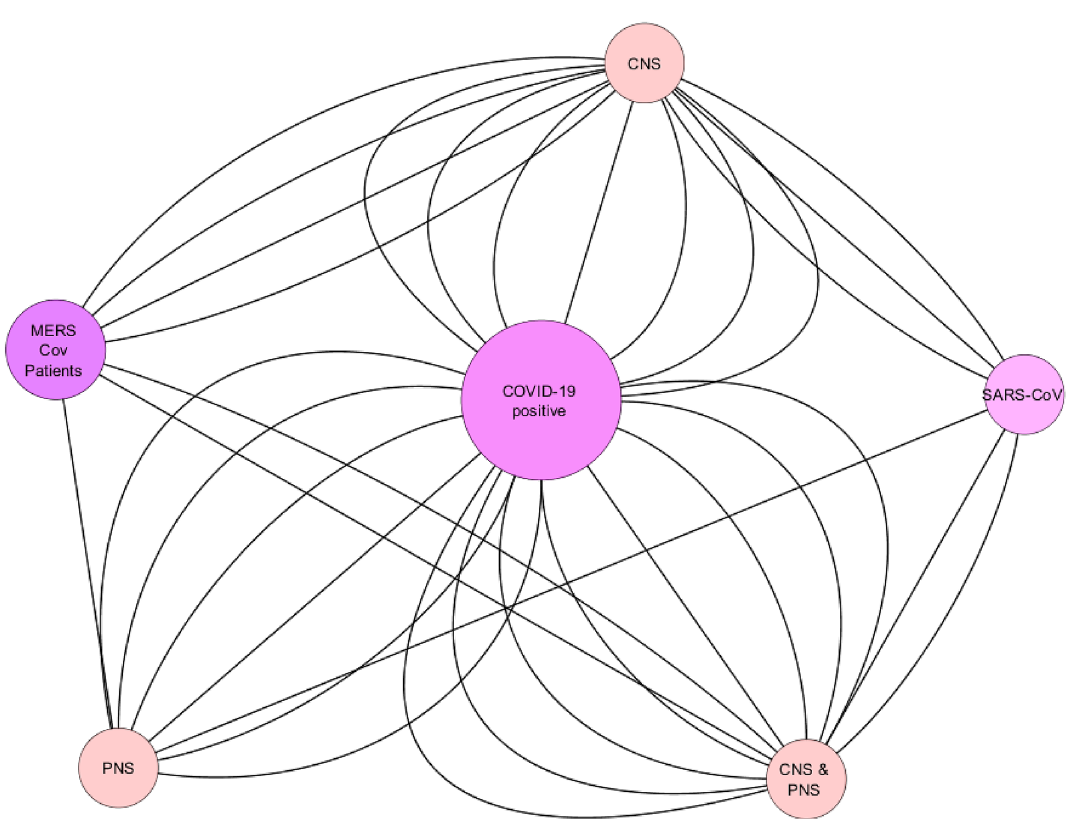
Figure 11. Overall Network analysis which showed the relationship with three main pandemics i.e., SARS- 2002, MERS-2012 and COVID-19 with the CNS, PNS or combined manifestations. Note : The size of node defines the degree of relation with the individual neurological symptoms and increased number of edges give the increased relation with the respective nodes. (Edges showing directed association, Node size depicts degree of